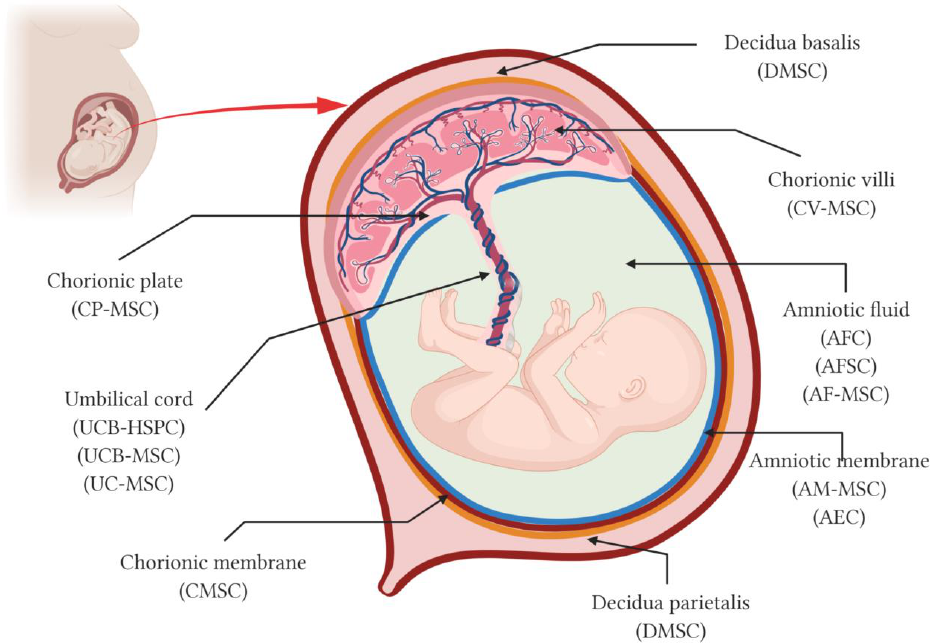
Figure 1. Schematic representation of perinatal tissues and perinatal stem cells. Anatomy of the human term placenta and its fetal annexes representing the main regions from which different types of perinatal stem cells have been isolated. AMSCs, amniotic membrane mesenchymal stromal cells; AEC, amniotic membrane epithelial cells; CMSCs, chorionic membrane mesenchymal stromal cells; CP-MSCs, chorionic plate mesenchymal stem cells; CV-MSCs, chorionic villi mesenchymal stromal cells; AFC, amniotic fluid cells; AFSC, amniotic fluid stem cells; AF-MSC, amniotic fluid mesenchymal stromal cells; UCB-HSPC, umbilical cord blood hematopoietic stem/progenitor cells; UCB-MSC, umbilical cord blood mesenchymal stromal cells; UC-MSCs, umbilical cord mesenchymal stromal cells; and DMSC, decidua-derived mesenchymal stromal cells. Created with BioRender.com.